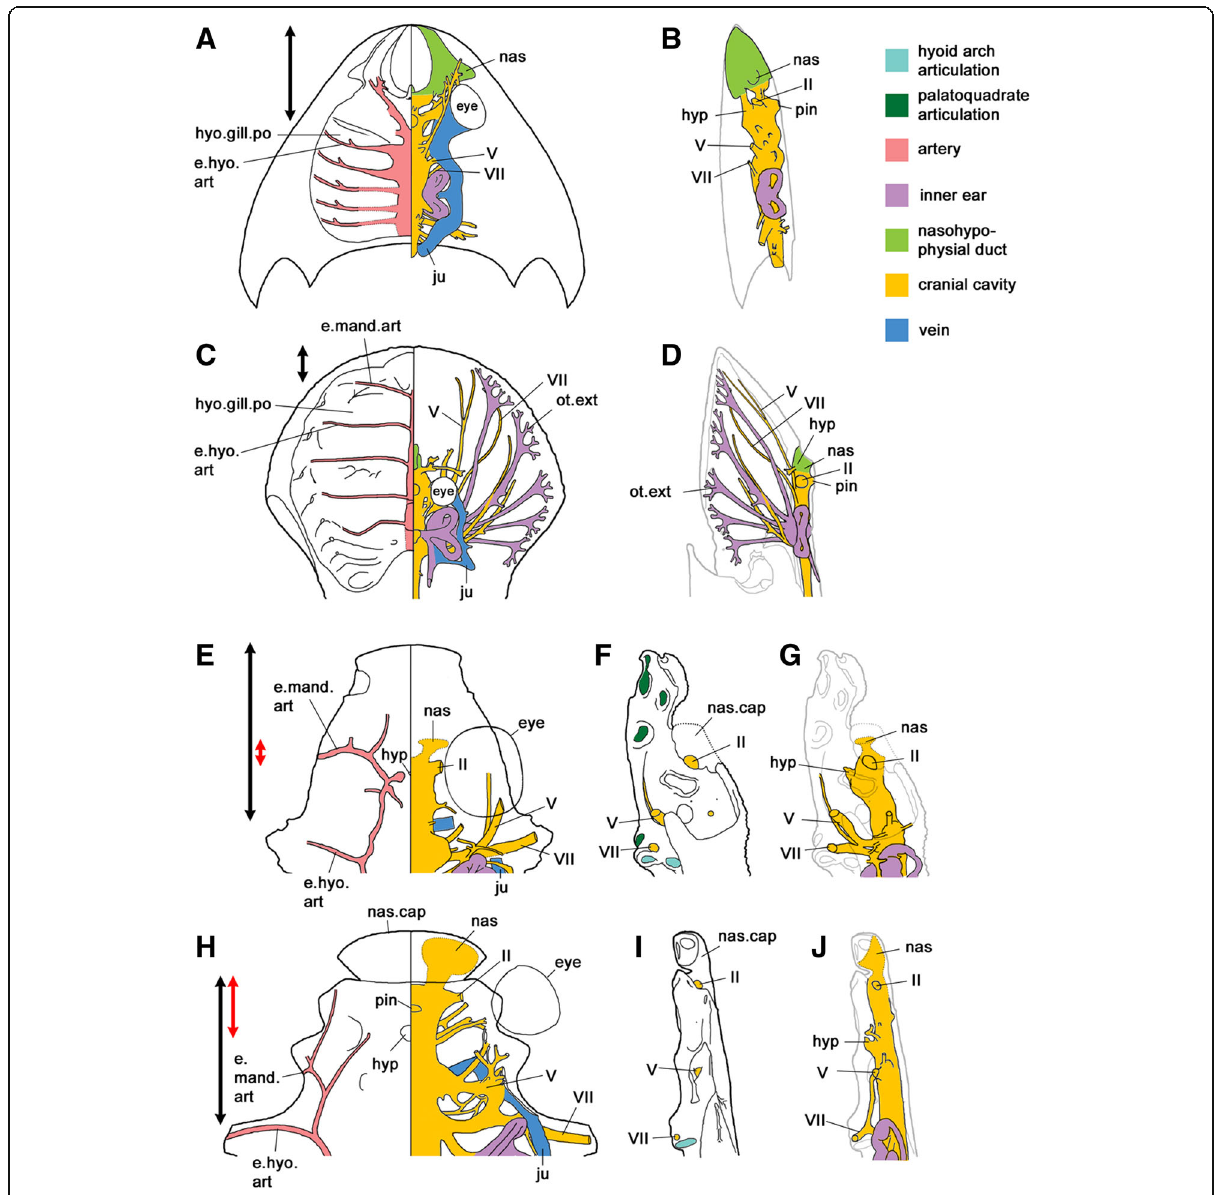
Fig. 5 Cranial anatomy of stem gnathostomes. a – b The galeaspid Shuyu , composite reconstruction based on reference [20]. a Combined ventral (left) and dorsal (right) image showing the arteries of the pharynx on the left, and the cranial cavity and associated structures on the right. b Lateral view showing cranial cavity, nasohypophyseal duct and inner ear. The double-headed black arrow indicates the length of the mandibular-premandibular region, measured from the anterior margin of the spiracular gill pouch to the tip of the snout. c – d The osteostracan Norselaspis , composite reconstruction based on reference [19]. In ( c ), note the anterior position of the pharynx compared to Shuyu , and the expansion of the saccular region of the inner ear into multiple long, branched canals (ot.ext) with a presumed sensory function. e - g The acanthothoracid (primitive placoderm) Romundina , redrawn from reference [22]. In this and the next taxon, only the anterior half of the neurocranium is shown. f Neurocranium in lateral view. g Cranial cavity in lateral view. In ( g ), note that the projecting precerebral part of the neurocranium is ventral to the cranial cavity. The nasal (or rostronasal) capsule is separated from the neurocranium by a fissure. The double-headed red arrow indicates the part of the neurocranium that floors the cranial cavity between the hypophysis and nasal sacs, and can thus be considered a trabecular region sensu stricto. Note that the inferred length of the mandibular-premandibular region (black arrow) is based on the position of palatoquadrate articulations and the exit of the hyomandibular trunk of n VII, and thus relates to the lateral margin of the neurocranium; in the midline the parachordal domain probably extends further forward. h-j The arthrodire (derived placoderm) Kujdanowiaspis , composite reconstruction based on reference [15]. The precerebral part of the neurocranium has been lost. As in Romundina , a fissure separates the rostronasal capsule from the neurocranium proper. e.hyo.art, efferent hyoidean artery; e.mand.art, efferent mandibular artery (generally termed efferent pseudobranchial artery in early gnathostomes); hyo.gill.po, hyoidean gill pouch; hyp, hypophysis; ju, dorsal jugular vein; nas, nasal sac; nas.cap, (rostro) nasal capsule; ot.ext., extension of the inner ear; pin, pineal foramen; II, optic nerve; V, trigeminal nerve; VII, hyomandibular branch of facial